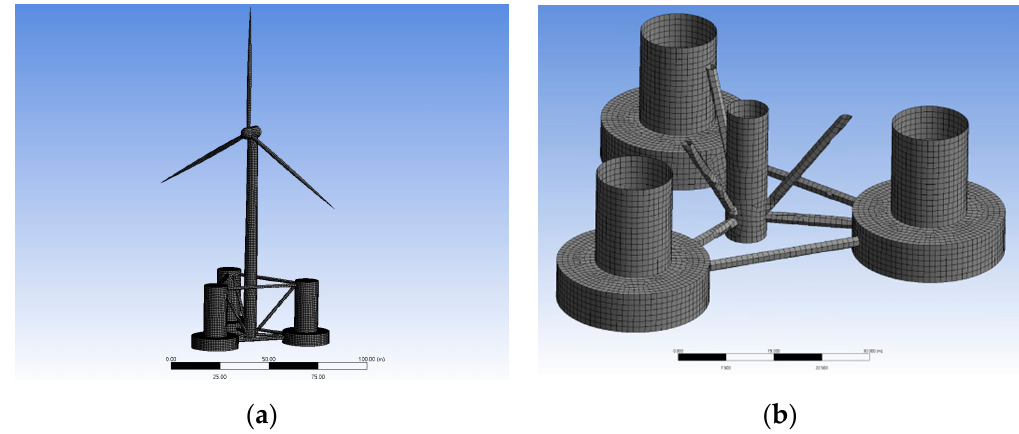
Figure 5. The mesh discretization: ( a ) semi-submersible FOWT; and ( b ) semi-submersible platform below the free surface.